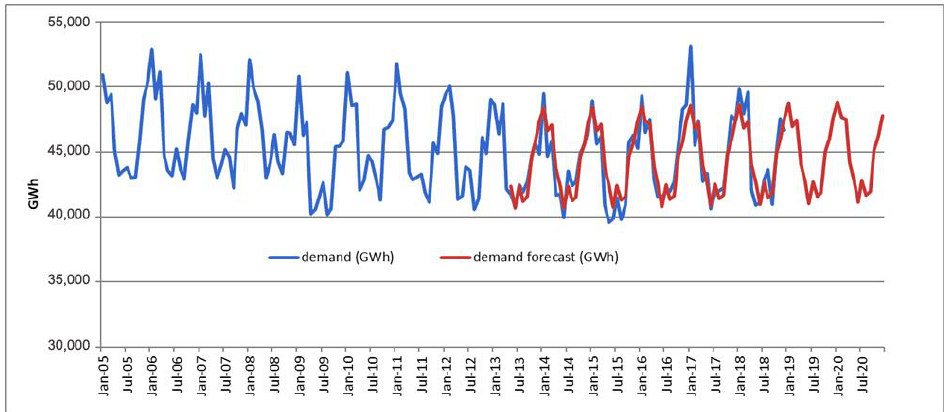
Figure 6. Germany, consumption by month, real vs forecast (source: entsoe.eu, modelled data).